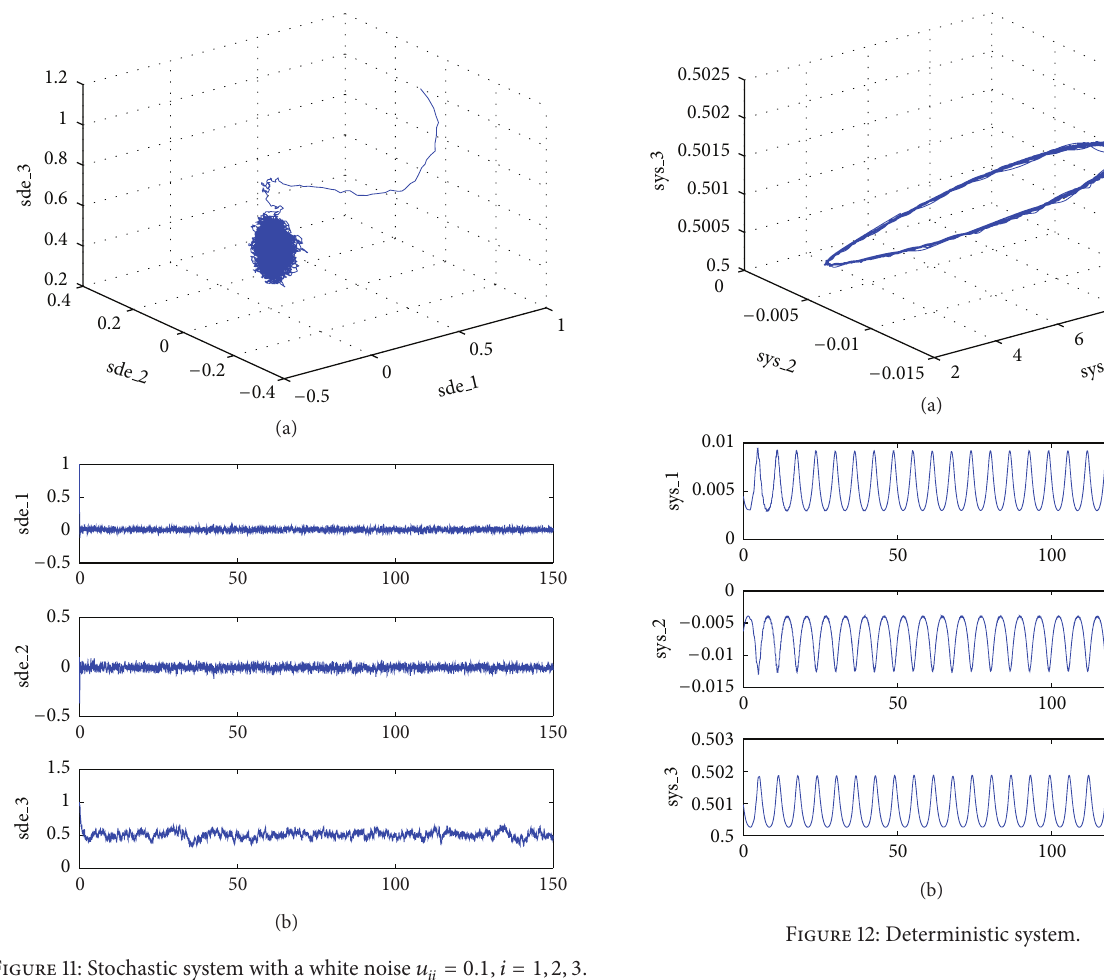
Figure 11: Stochastic system with a white noise 𝑢 𝑖𝑖 = 0.1 , 𝑖 = 1, 2,3 .